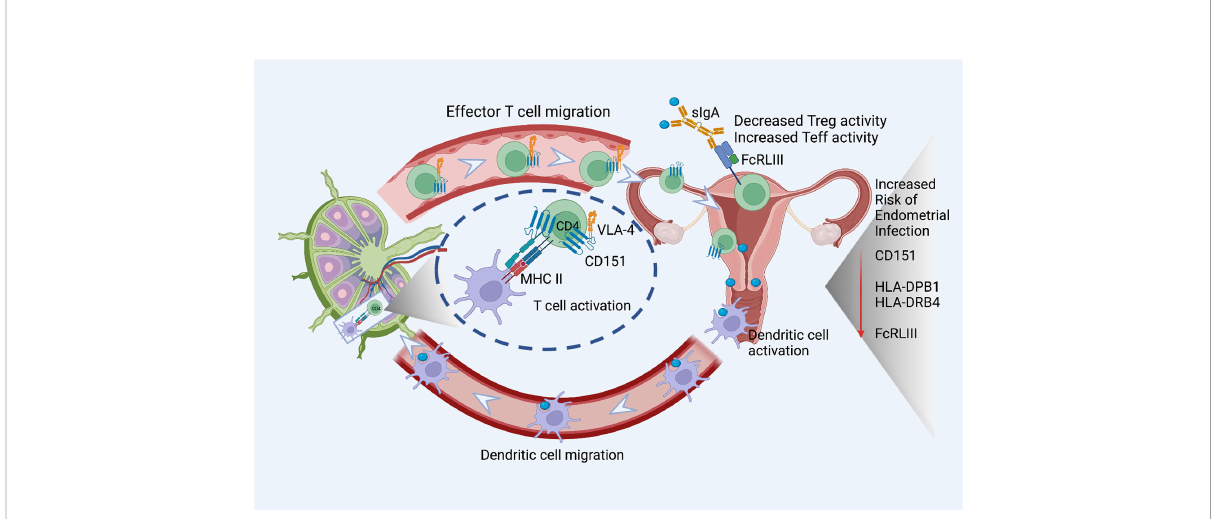
FIGURE 3 eGenes important for T cell activation, function, and migration downregulated in women with endometrial infection include: CD151, a tetraspanin intimately involved in the T cell/antigen presenting cell synapse that also interacts with integrins to promote T cell migration; MHC Class II molecules important for antigen presentation to CD4 T cells, HLA-DPB1 and HLA-DRB4; and FcRLIII, that binds bacterial-speci fi c sIgA at mucosal surfaces to inhibit T suppressor functions and enhance T effector functions. The fi gure was created using